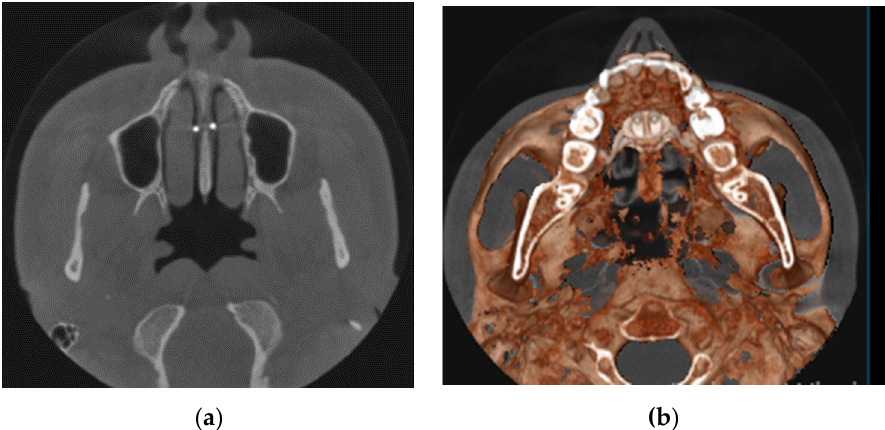
Figure 5. Rendering axial images showing FOV images used in the study before the palatal split. ( a ) Micro-implants in position, ( b ) Device in position.